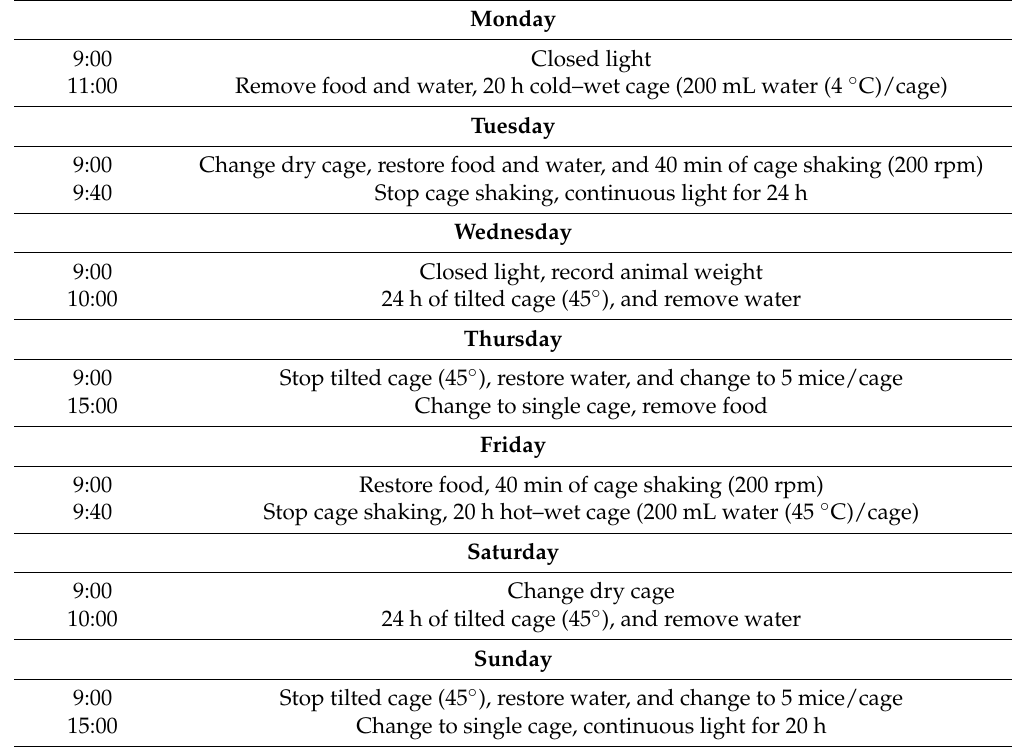
Table 1. The procedure of